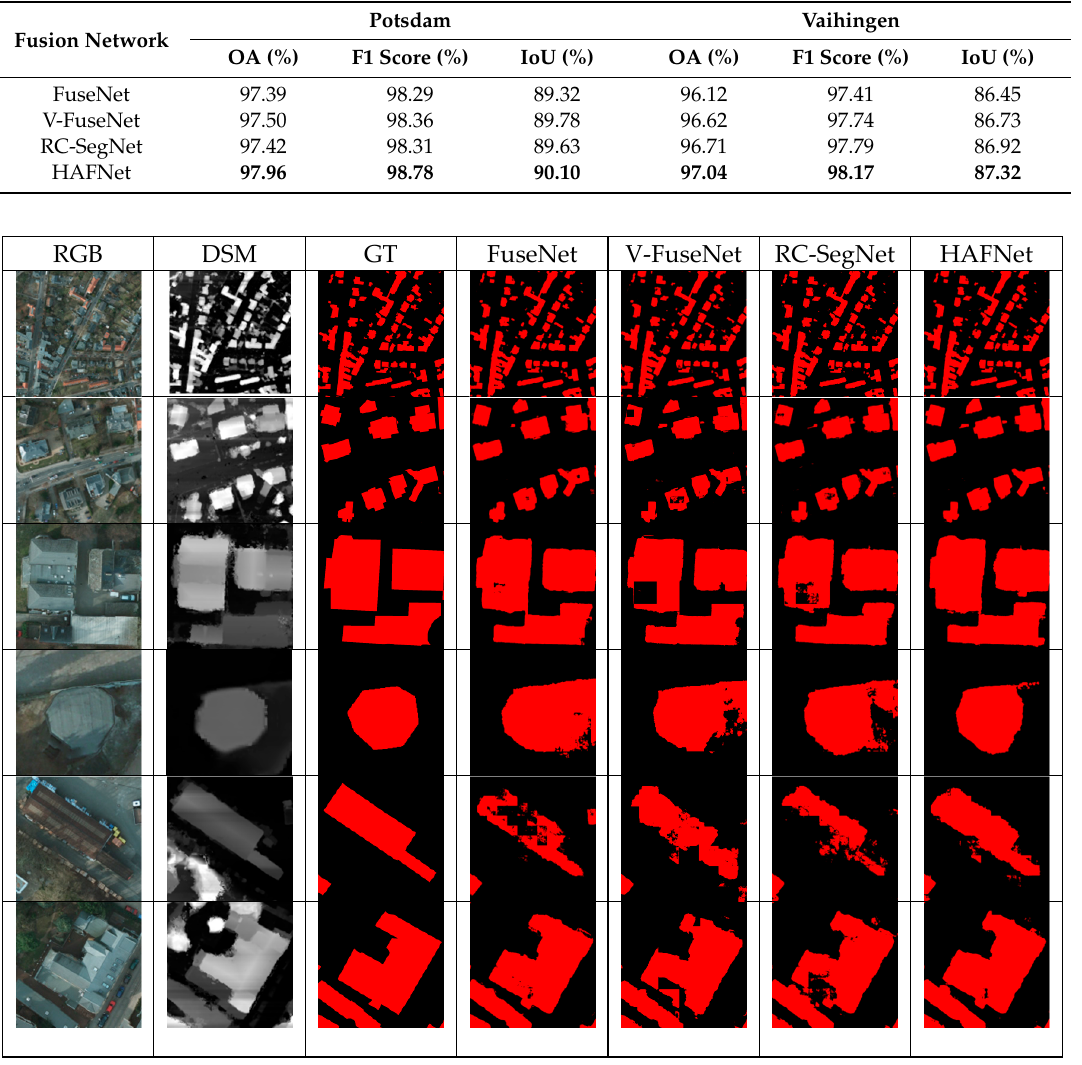
Figure 9. Building extraction results using FuseNet, V-FuseNet, RC-SegNet, and HAFNet. Table 6. Quantitative results of FuseNet, V-FuseNet, RC-SegNet, and HAFNet.